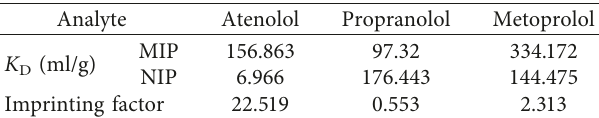
Table 3: Selectivity of MMA propanol polymer by precipitation polymerization ( n �